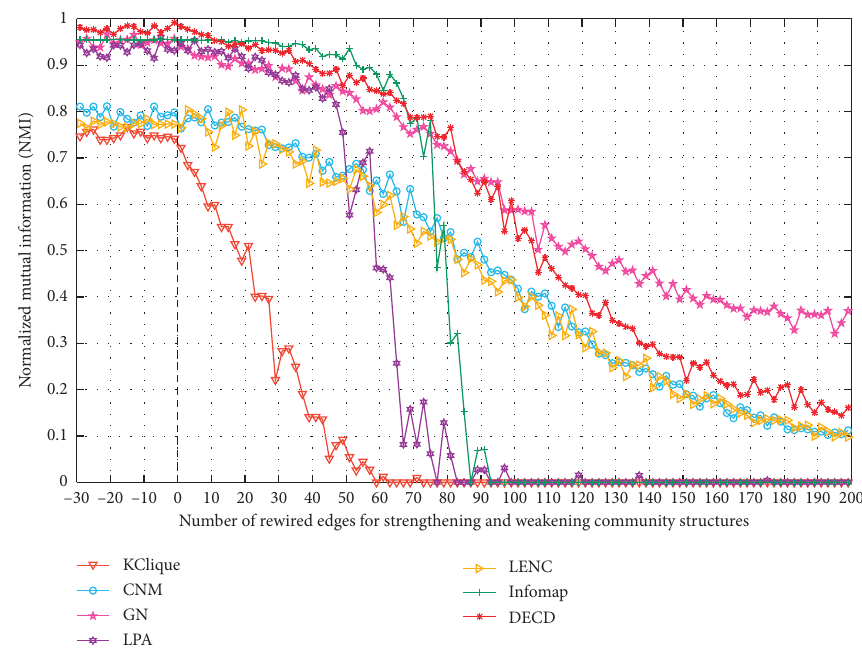
Figure 5: The average optimal value of NMI obtained by typical community detection algorithms on a set of benchmarks with gradually modified community intensity, which are generated based on the American College Football (ACF) network. Each data point is obtained based on averaging 10 independent runs of each algorithm on each benchmark. The negative and positive values of the abscissa represent the number of rewired edges when the community structure is strengthened and weakened,